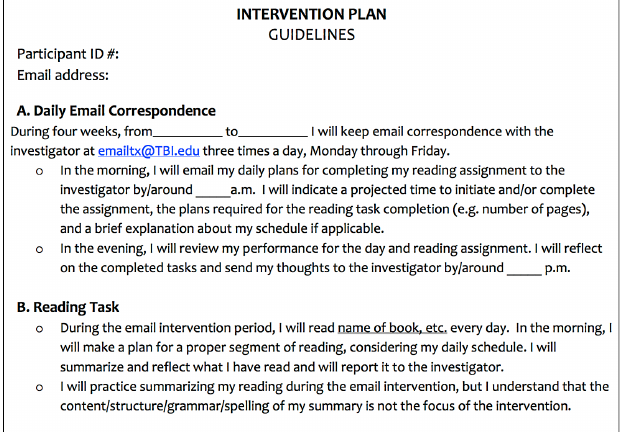
Table 2 A Sample Intervention